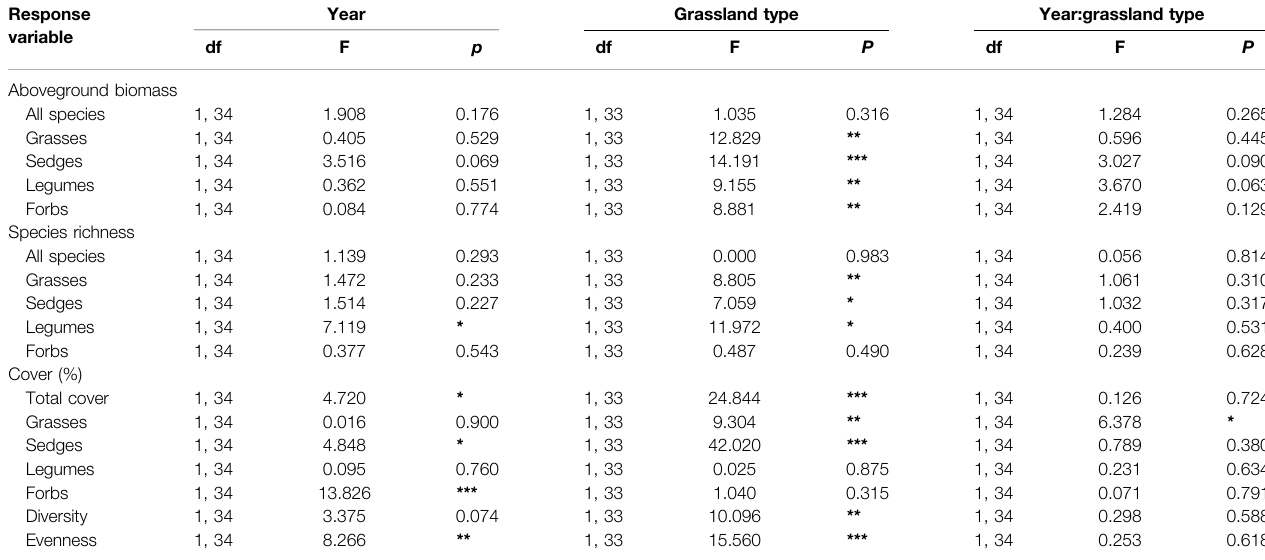
TABLE 1 | Results of the mixed effect model testing for the effects of year (2008 vs. 2018), grassland type (meadow vs. steppe), and the interaction between year and grassland type on aboveground biomass, species richness, and plant cover of all species, grasses, sedges, legumes, and forbs, and diversity and evenness. Asterisks denote signi fi cant differences at p < 0.05*, p < 0.01**, p <